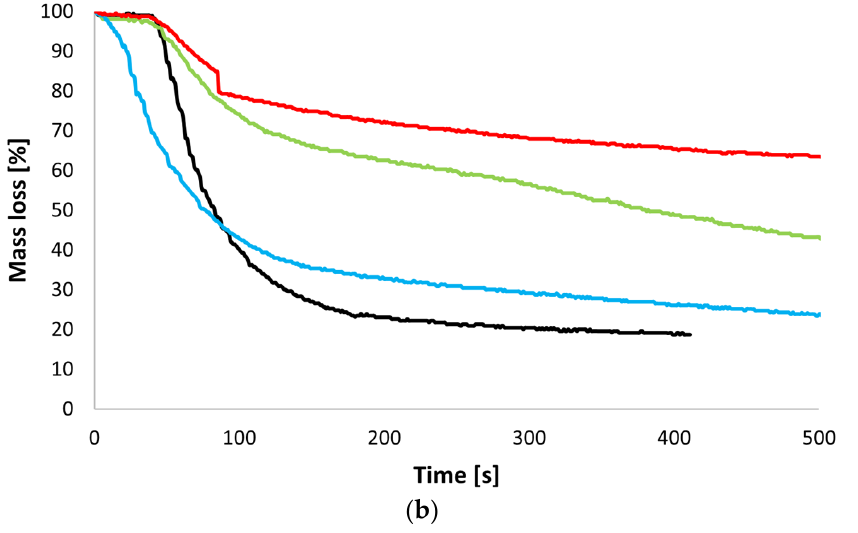
Figure 2. The heat release rate ( a ) and mass loss ( b ) of the reference and flame retardant gel coatings.